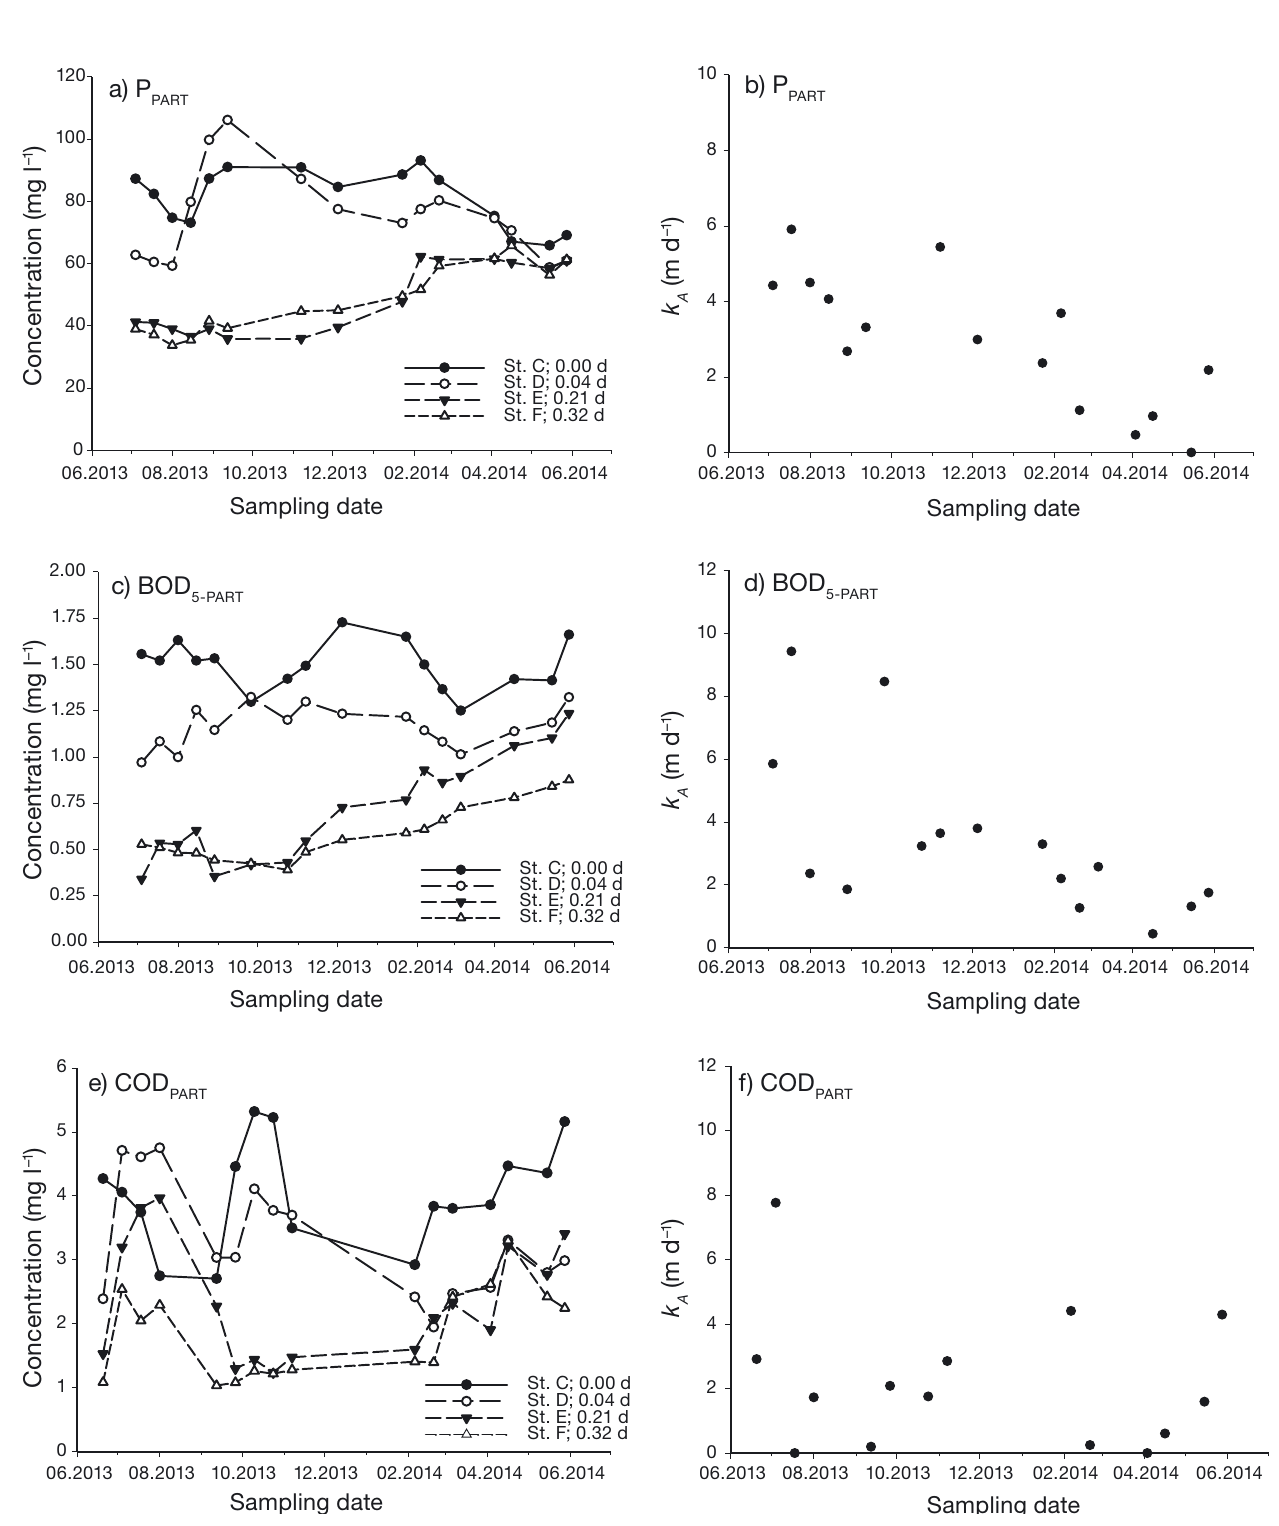
Fig. 4. Concentrations (a,c,e; running averages of 3 concurrent sampling events) of particulate (PART) phosphorus (P; a), 5 d biochemical (BOD 5 ; c) and chemical (COD; e) oxygen demand measured at increasing hydraulic retention time (HRT, in d) relative to the wetland inlet station (Stn C, cf. Fig. 1) during the year of bi-weekly sampling. Also shown is the corresponding area-based reaction coefficients ( k A , m d −1 ; b,d,f). Background concentrations used for fitting first order kinetic plug flow models to the longitudinal transect data and deriving the k A values are summarized in Table